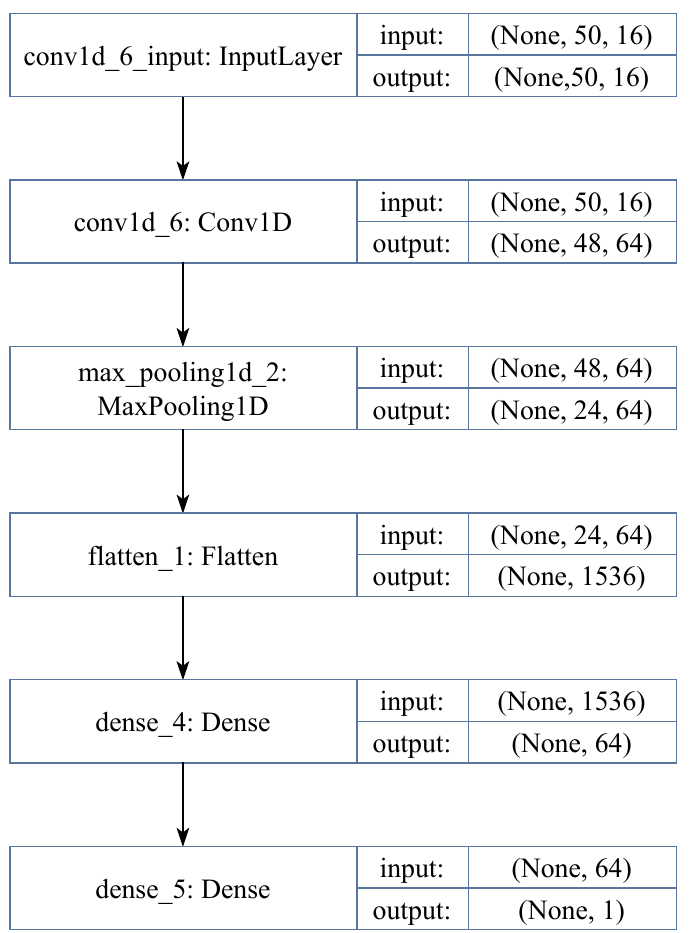
Figure 14. Visualized proposed CNN architecture (adapted from [14,44]).